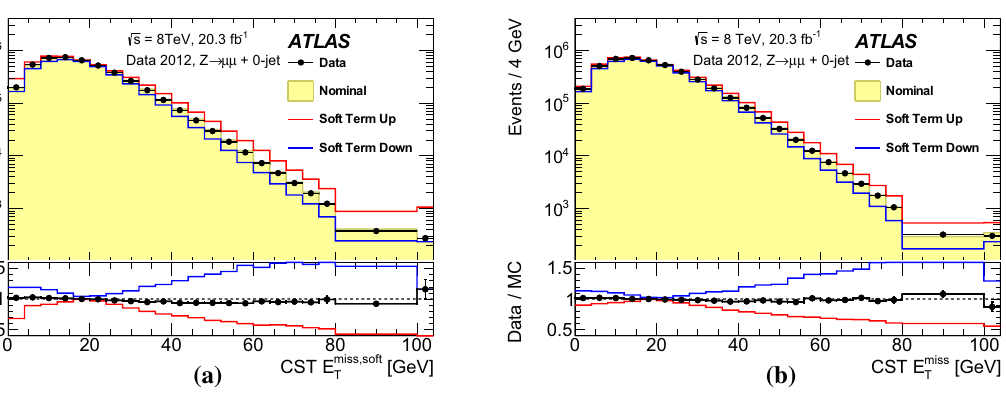
Fig. 26 using the Z → μμ + 0-jet control sample, where the uncertainty band is the quadratic sum of the variations with the MC statistical uncertainty. The systematic uncertainty band for the TST is larger in Fig. 26a than the one for the pri- mary CST algorithm. In all the distributions, the systematic uncertainties in the soft term alone cover the disagreement between data and MC simulation.